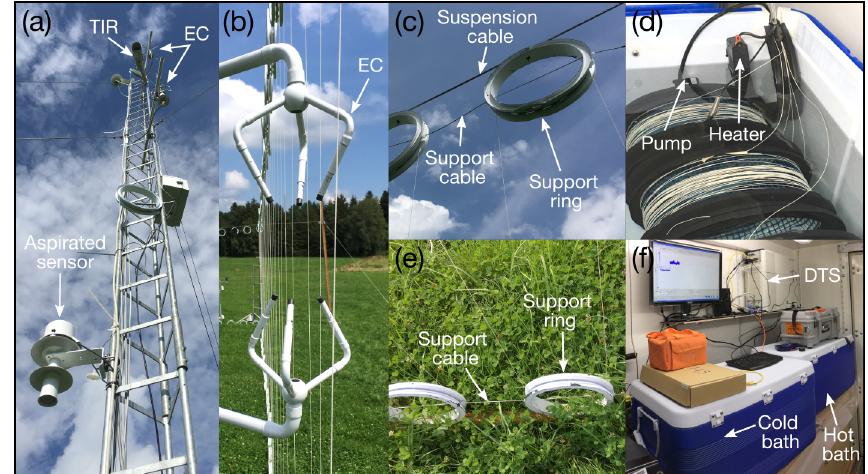
Figure A1. Details of the field setup showing (a) a close-up of the 9m mast, (b) a view along a vertical plane of DTS profiles, (c, e) details of the DTS support structure, (d) a view inside a calibration bath and (f) the DTS instrumentation.